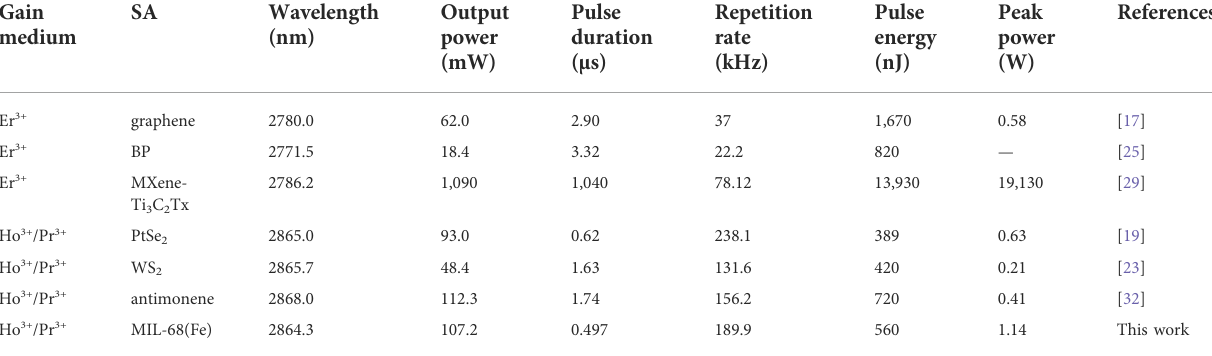
TABLE 2 Comparison of this work with other selected 2D-materials for the three-micron region. Gain